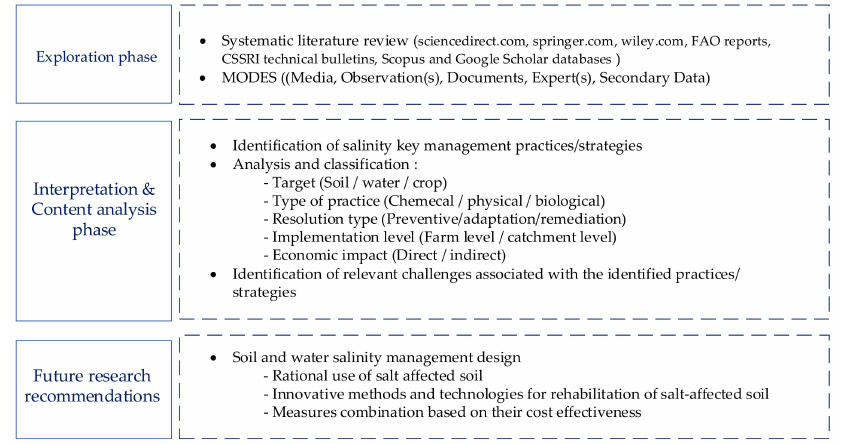
Figure 2. Methodology